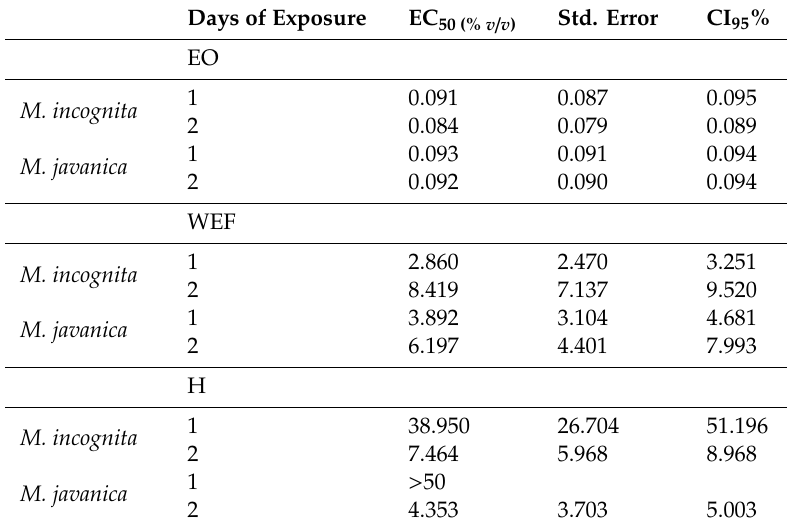
Table 2. EC 50 (% w / v ) values of M. incognita and M. javanica calculated after immersion of J2s in test solutions of EO, WEF and H for 1 and 2 days.